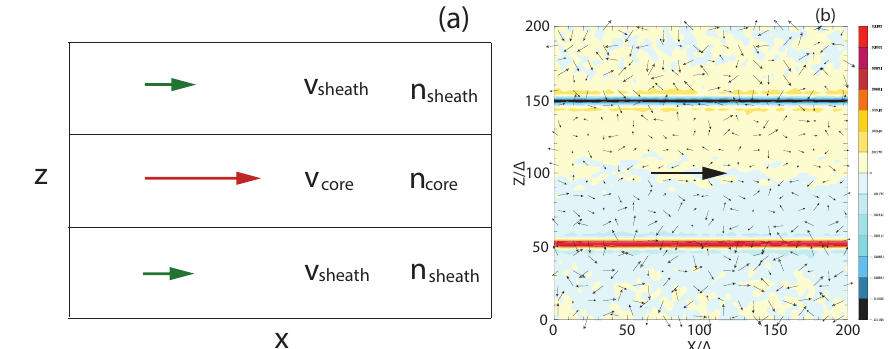
is plotted in the x z plane (jet flow in the + x - y − 1 = 15 and for the case of γ z plane (jet flow in the + x - − j pe − for the case of γ j = 15 and pe